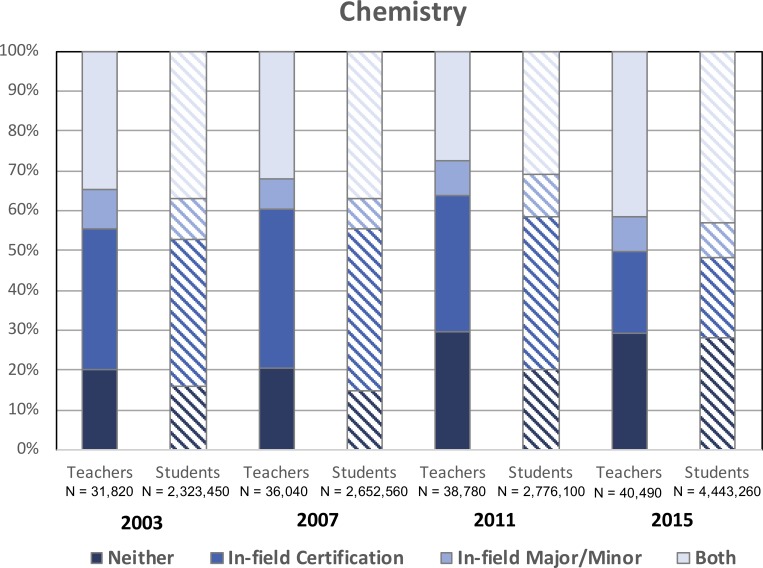
Percentages of in-field and out-of-field high school chemistry teachers and high school chemistry students assigned to these educators from 2003–2015.CVteachers < .013; CVstudents < .008. SEteachers ≤ 8%; SEstudents ≤ 5%.